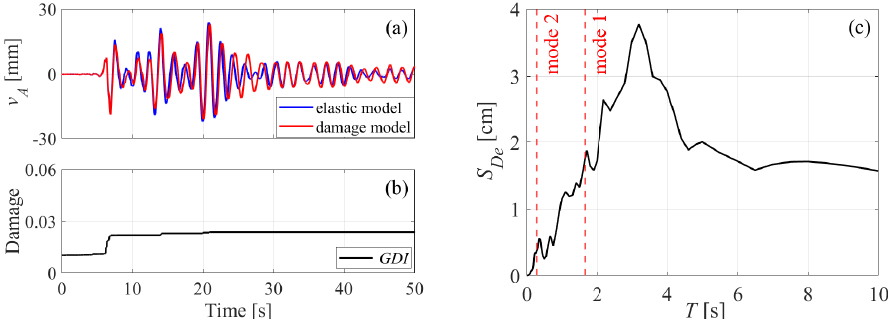
Figure 14. Earthquake ACC station: ( a ) elastic and damage responses of the equivalent pier, ( b ) evolution of the GDI , ( c ) elastic displacement